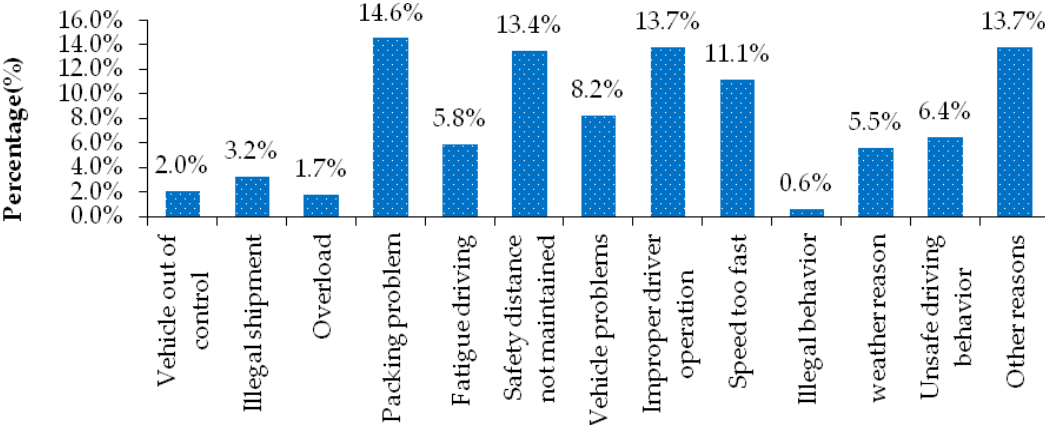
Figure 1. Percentage of the causes of hazardous materials transportation accidents.